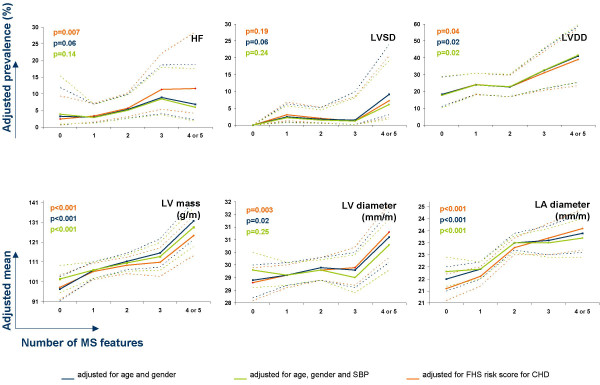
Adjusted prevalence of stage C of heart failure (HF), left ventricular systolic dysfunction (LVSD) and left ventricular diastolic dysfunction (LVDD) according to number of features of the metabolic syndrome, estimated by multiple linear regression (upper panel). Adjusted mean of left ventricular (LV) mass, LV diameter and left atrial (LA) diameter, all indexed to height, according to number of features of the metabolic syndrome estimated by multiple logistic regression (lower panel). In each chart, three models are presented: adjusting for age and gender (blue line), adjusting for the predicted 10-year risk of coronary heart disease by the Framingham risk score (orange) and adjusting for age, gender and systolic blood pressure (green). The dotted lines represent 95% confidence intervals of estimates. P values are for linear trend and were estimated by running the same models with the number of features of the metabolic syndrome as a continuous variable.